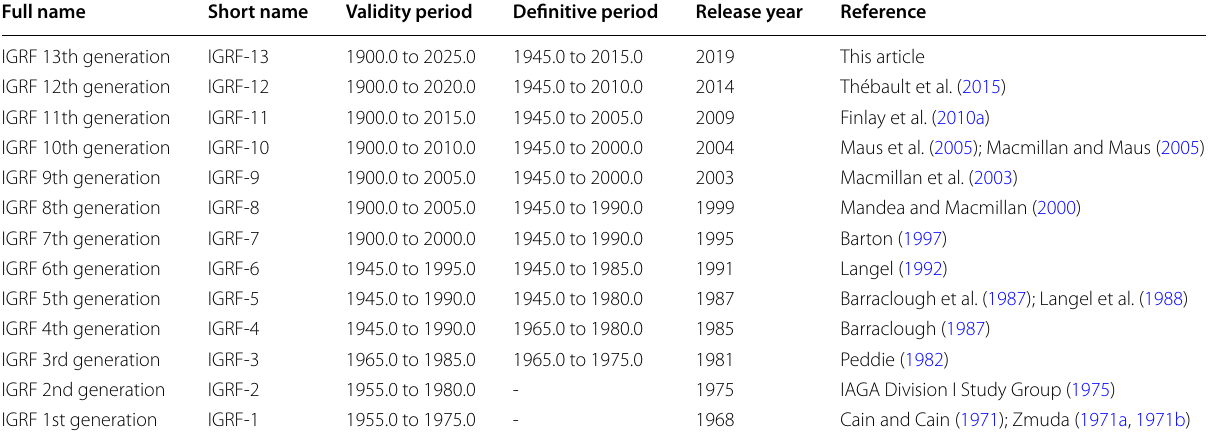
Table 1 Summary of IGRF generations, validity periods, release years, and